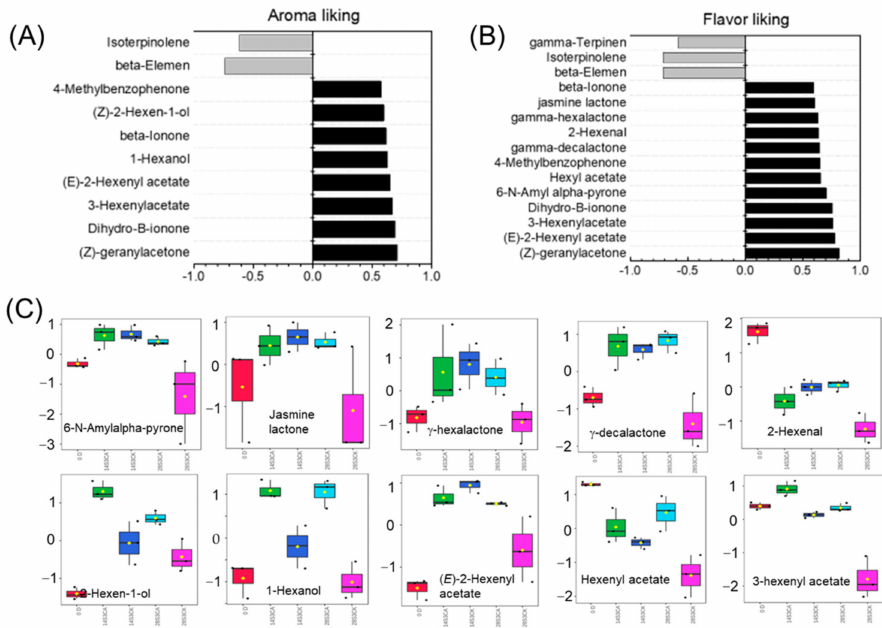
Figure 5. Identified peach fruit volatiles shown significant correlation with aroma- and flavor-liking during CA storage. ( A ) Volatiles correlated with aroma-liking; ( B ) Volatiles correlated with flavor- liking; ( C ) Content of the positively correlated